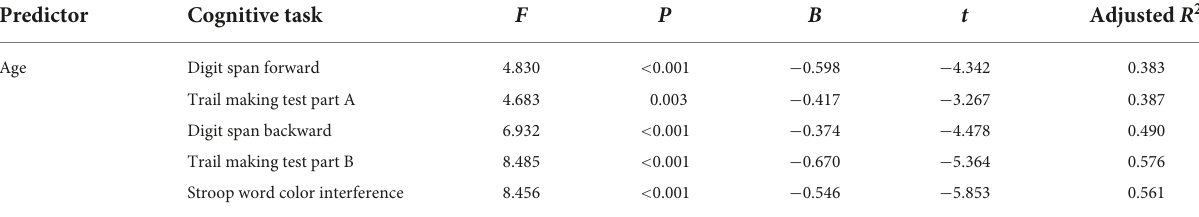
Attention/processing speed Working memory Executive function Digit span Trail making Digit span Trail making forward test part A backward test part B